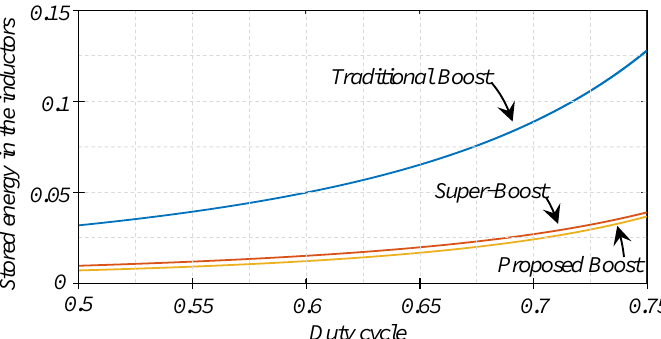
Figure 10. Comparison of stored energy in capacitors between the traditional boost, the super-boost converter, and the proposed converter for a case with the same output voltage ripple. converter, and the proposed converter for a case with the same output voltage